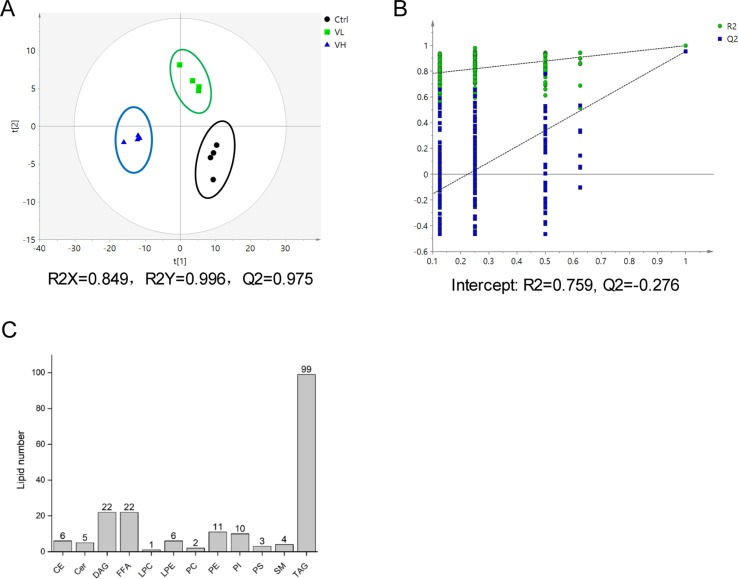
(A) Score plot of the PLS-DA model based on UV scaling for the VL group (green boxes), VH group (blue triangles), and control (black dots) separation (n = 4). (B) Cross-validation plot of PLS-DA mode with 200 times permutation tests. (C) Number of detected lipids based on a nontargeted lipidomic strategy in L02 cells treated with VPA.